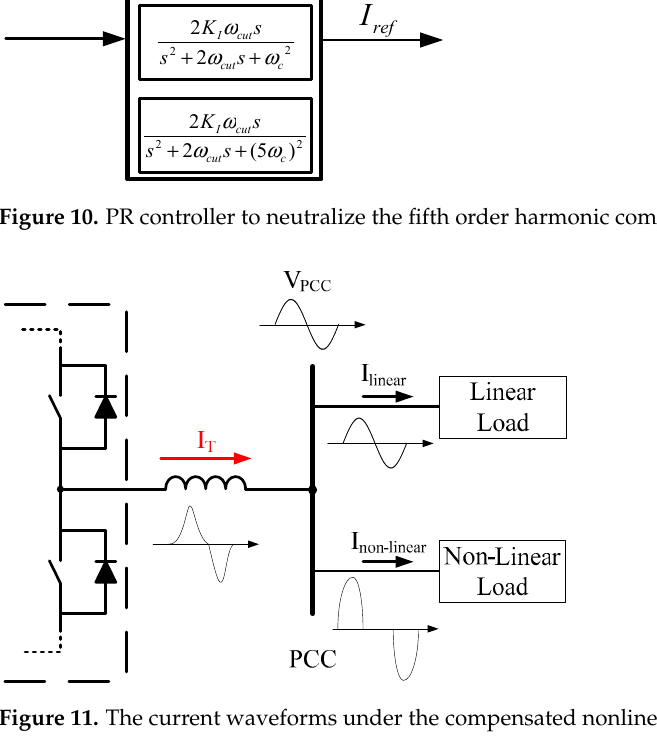
Figure 10. PR controller to neutralize the fifth order harmonic component.